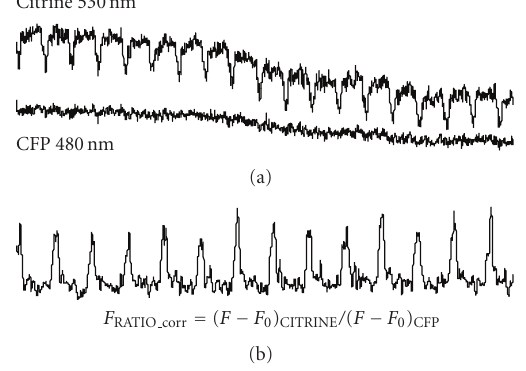
Figure 7: (a) Original recordings from cells expressed troponeon at the excitation wavelength of (a) 485 and 535 nm and (b) the characterized calcium transient by ratio of the fluorescence intensity (FCFP 485 / FCITRINE 535) from one day after